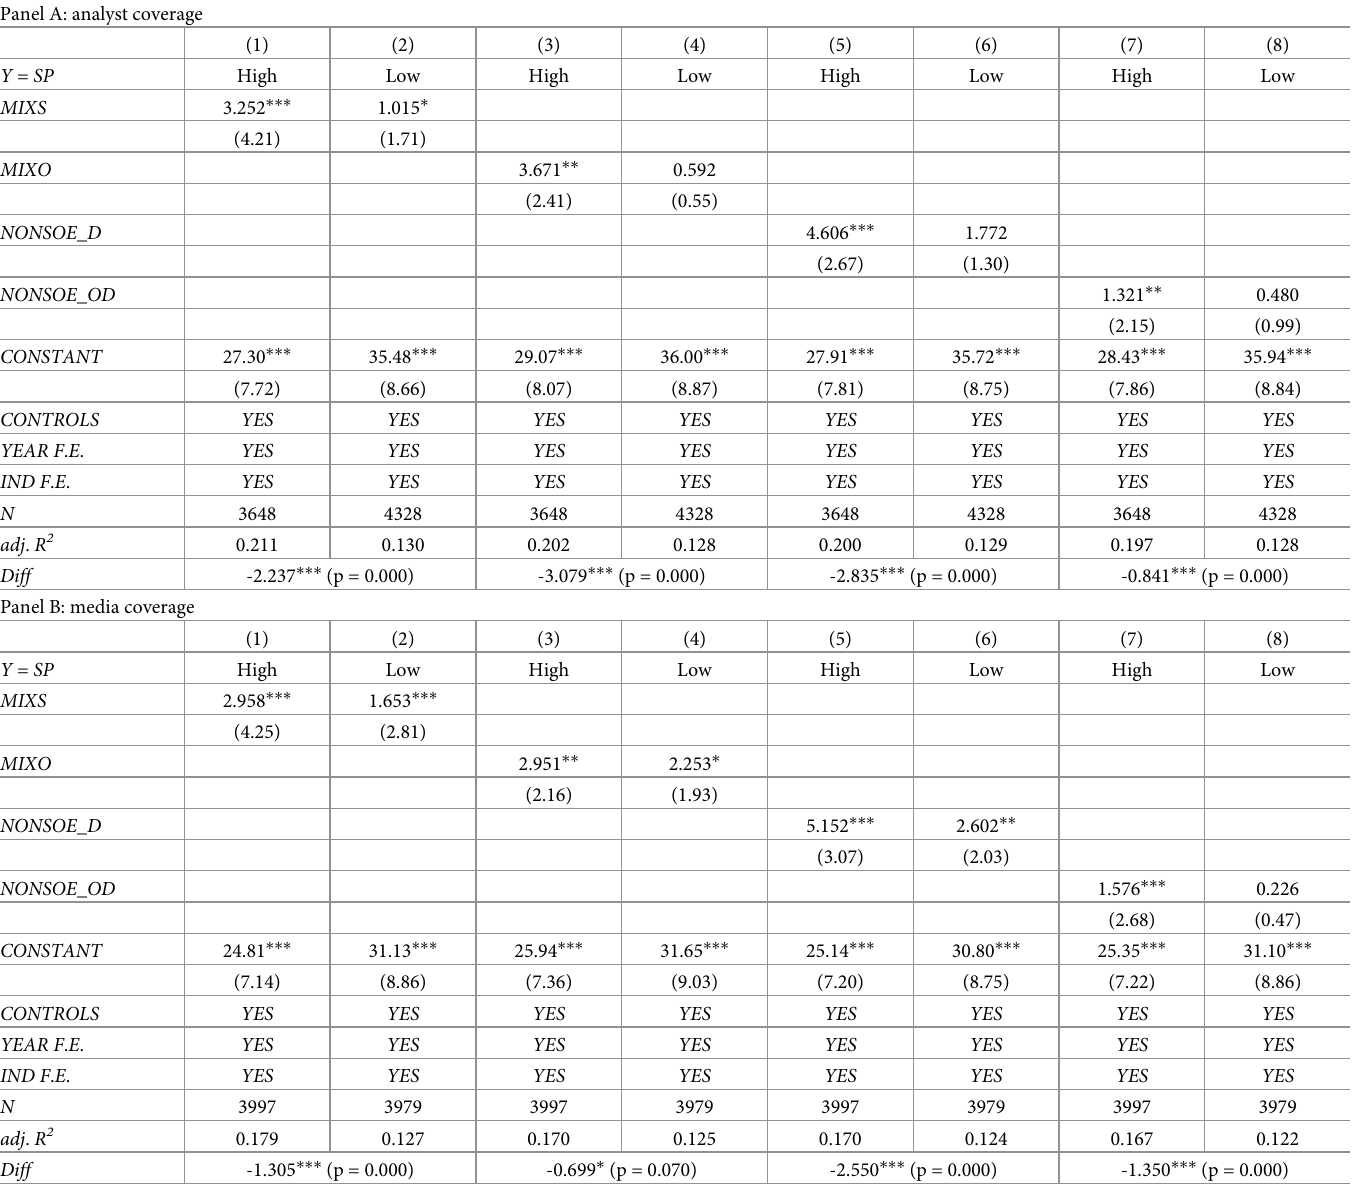
Table 12. The group inspection results of external